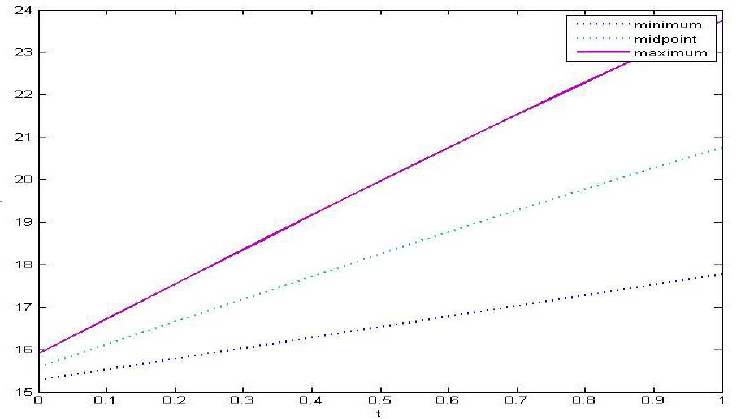
Figure A2. Plot of the maximum, center, and minimum of infected humans under the intervals (cid:2010)(cid:3560) =